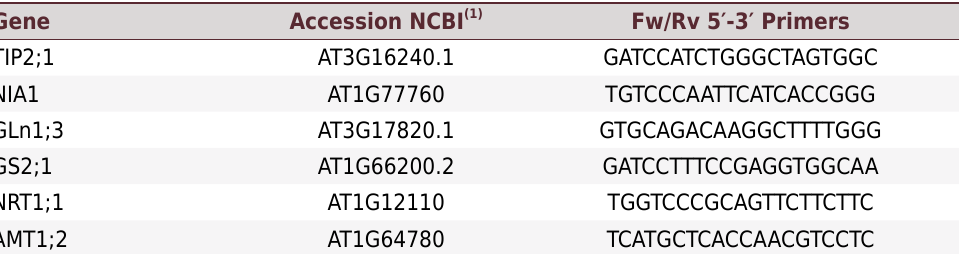
Table 1. Primers used for